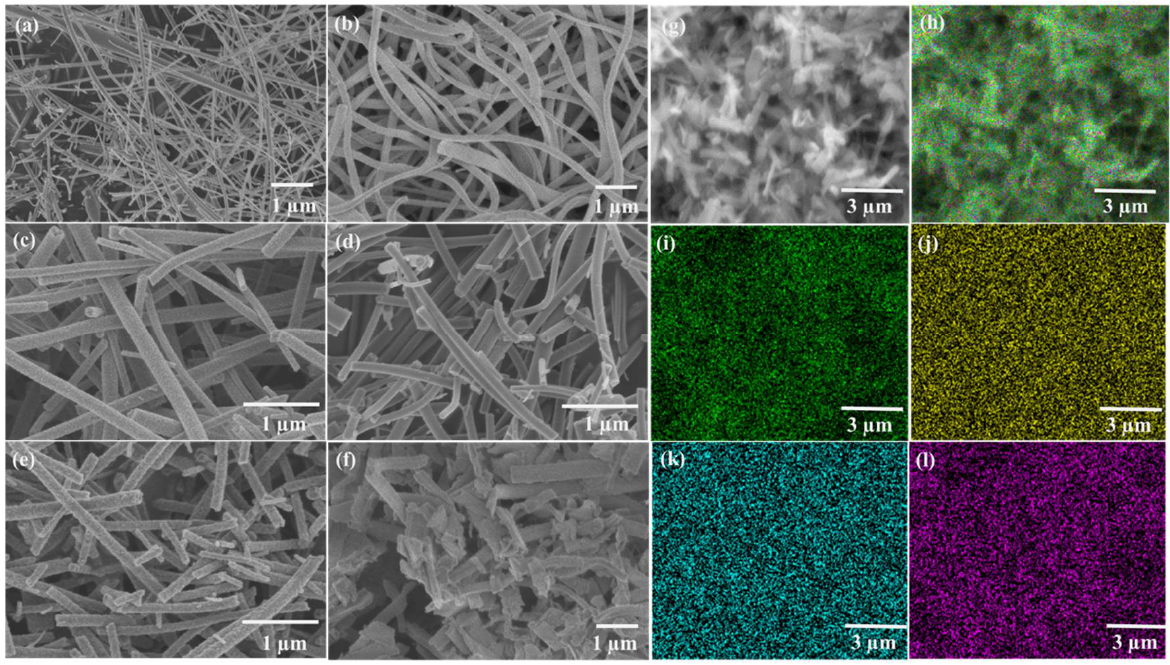
Figure 3. SEM images for ( a ) TW0, ( b ) TW10, ( c ) TW20, ( d ) TW30, ( e ) TW40 and ( f ) TW50 nanofibers; ( g , h ) Images of SEM/EDX elemental mapping of TW40 ( i ) oxygen, ( j ) titanium, ( k ) tungsten and ( l ) sulfur in TW40.